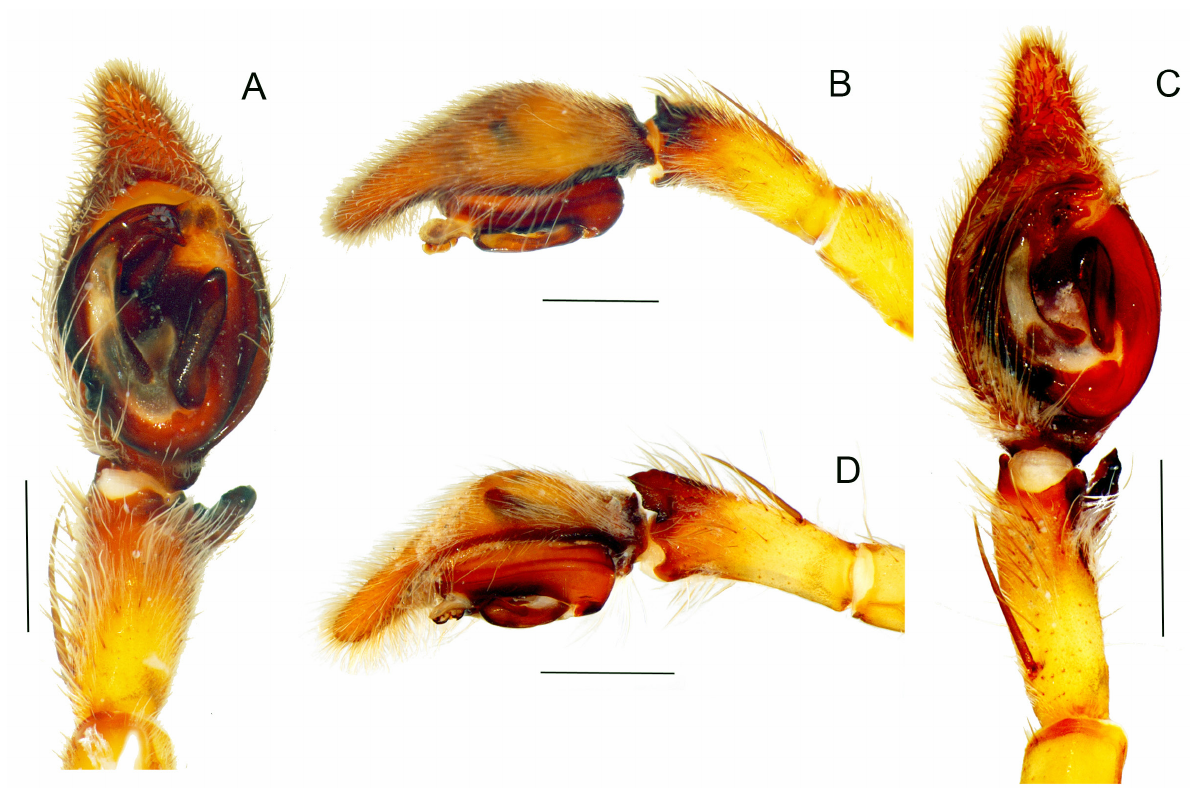
Fig. 13. Male palp. — A–B . Afroneutria velox (Blackwall, 1865) comb. nov. A . Ventral view. B . Retrolateral view. — C–D . Afroneutria hybrida sp. nov. C . Ventral view. D . Retrolateral view. Scale bars = 1